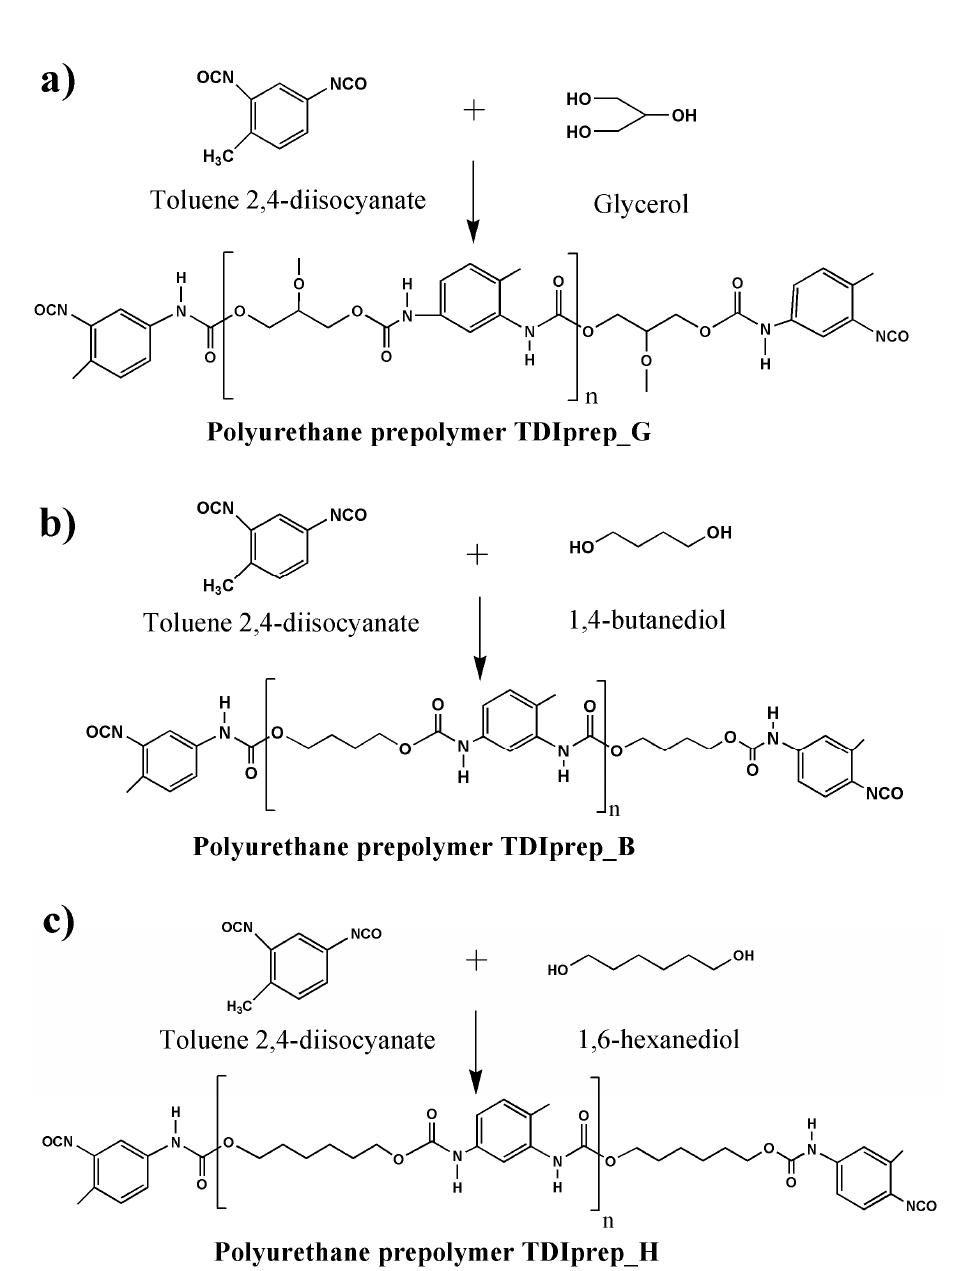
Figure 1. Schematic presentation of prepolymer synthesis, using toluene 2,4 ‐ diisocyanate and glycerol ( a ), 1,4 ‐ butanediol ( b ), or 1,6 ‐ hexanediol ( c ).